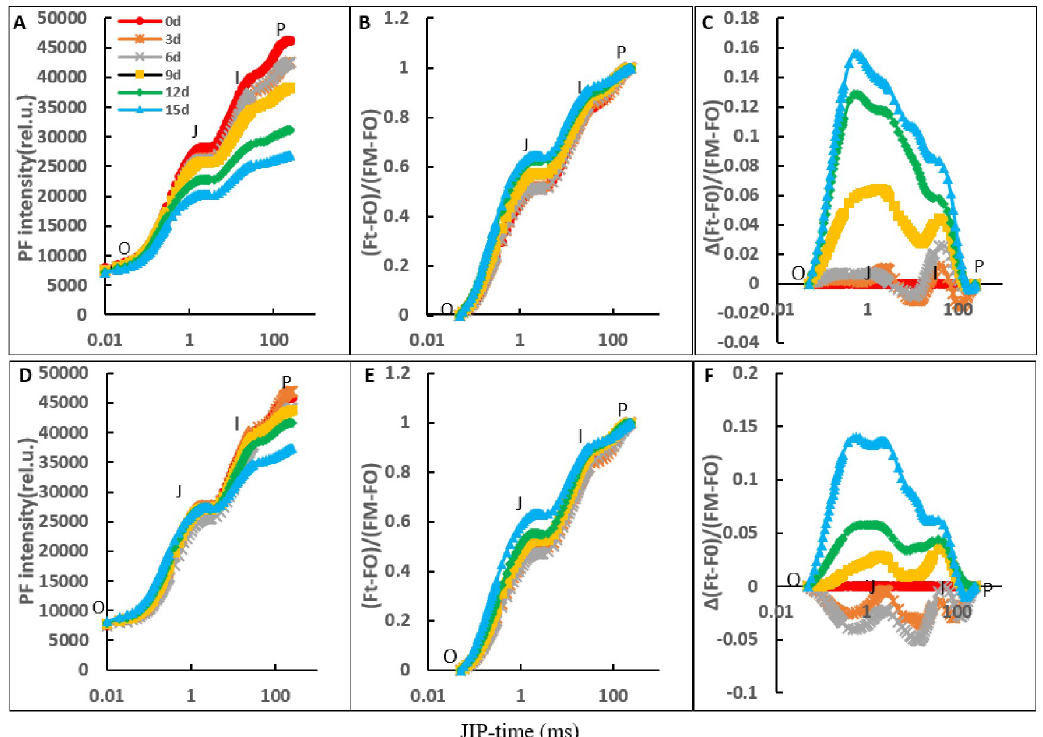
Fig 2. The curves of PF transients of oat leaves in the NaCl treatment and the NaCl treatment with CaCl 2 amendment on the day of NaCl stress and on days 3, 6, 9, 12, and 15 of NaCl stress. (A, B, C) PF intensity (rel.u.), normalized transients and Δ V t curves in single NaCl treatment. (D, E, F) PF intensity (rel.u.), normalized transients and Δ V t curves in the NaCl treatment with CaCl 2 amendment. The signals were plotted on a logarithmic time scale (JIP Time). Each value of the curves is the average of 3